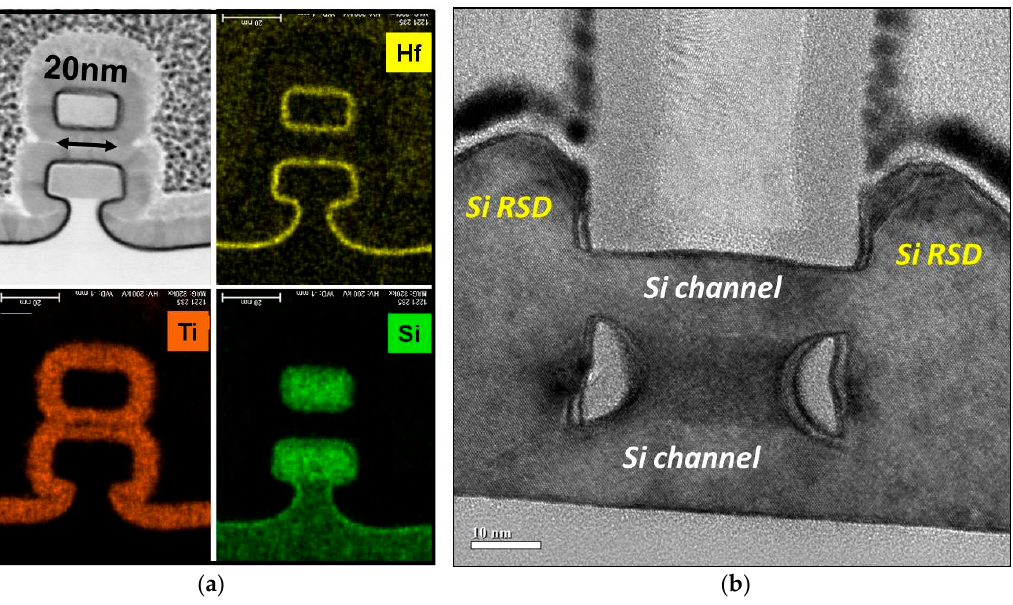
Figure 14. Example of nanowire transistors considered in this work: ( a ) cross section, including identification of Hf, Ti, and Si layers; ( b ) cut along source-drain direction, with SiN inner spacers.